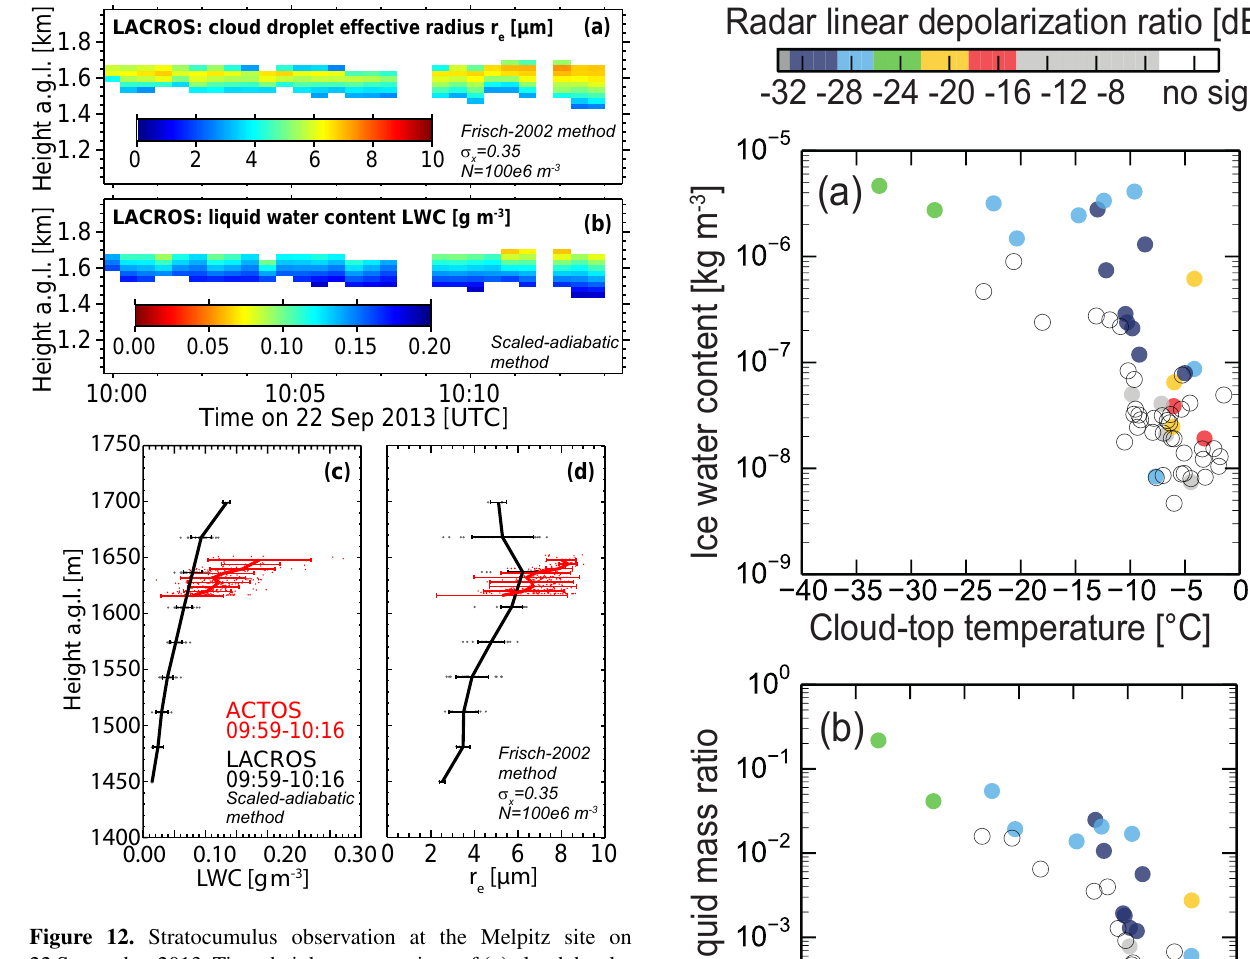
10 − 4 g m − 3 . At temperatures below − 15 ◦ C, values of the IWC vary around 10 − 3 g m − 3 . The ice-to-liquid mass ra- tio decreases from 10 − 2 to 10 − 5 for temperatures increas- ing from − 40 to 0 ◦ C. The plots thus quantify how ice for- mation becomes more efficient with decreasing temperature. The colour-coded data points in Fig. 13 provide in addi- tion the radar-observed linear depolarization ratio of the ob- served ice particles, which is a proxy for the particle